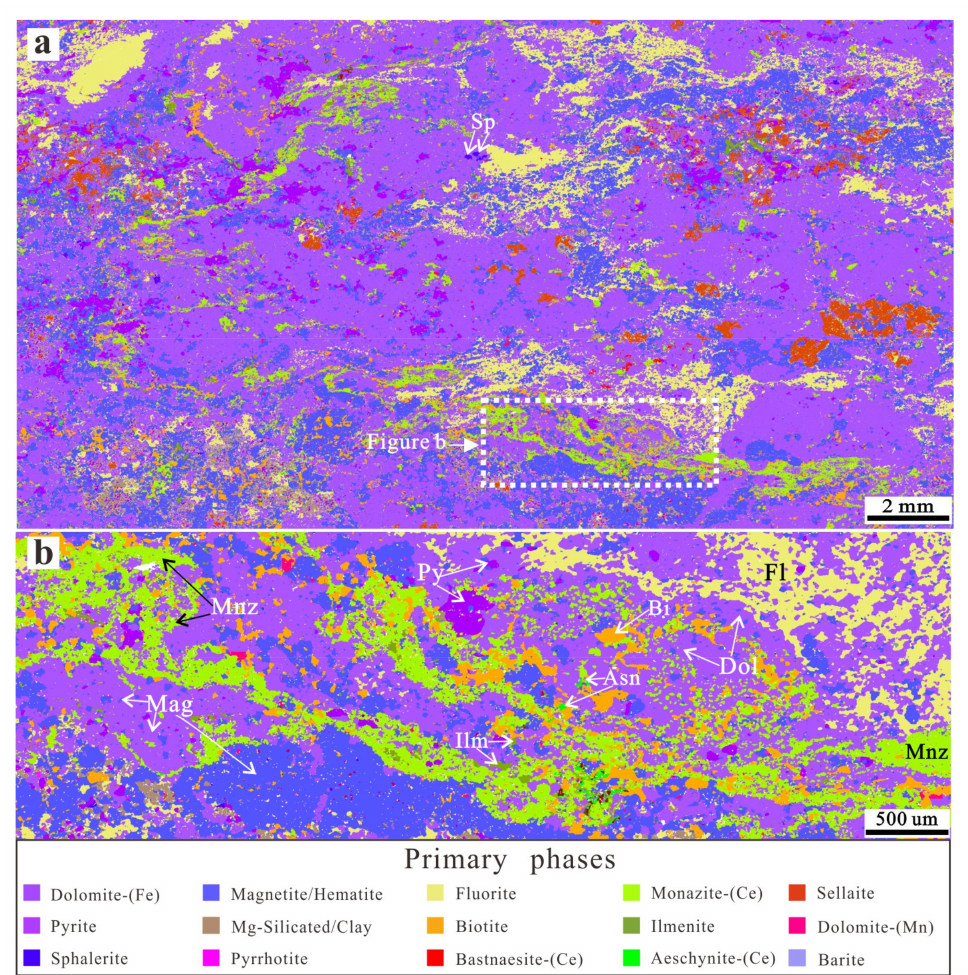
Figure 6. The TIMA false-colored mineral phase map of the 1246 m drill core sample. ( a ) the whole image of the polished thin section shows disseminated ore texture; ( b ) subhedral to anhedral monazite-(Ce) associated with fluorite, magnetite, biotite, and pyrite, overprinted on dolomite-(Fe). Abbreviations: Dol, dolomite-(Fe); Mnz, monazite-(Ce); Fl, fluorite; Mag, magnetite; Py, pyrite; Bi, biotite; Sp, sphalerite; Ilm, ilmenite; Asn,